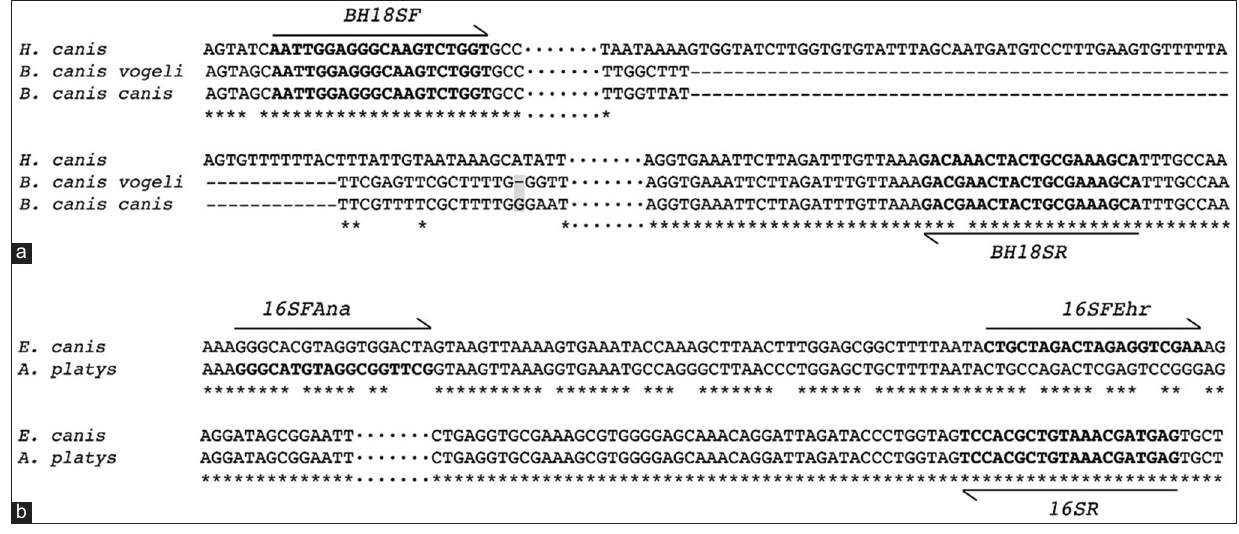
Figure-1: Simplified DNA alignment showing polymorphic regions targeted in primer design of (a) 18S rDNA and (b) 16S rDNA. Dot symbols show omitted regions that may not be involved in the result interpretation and discussion. Shaded area shows the 1-bp insertion between Babesia canis